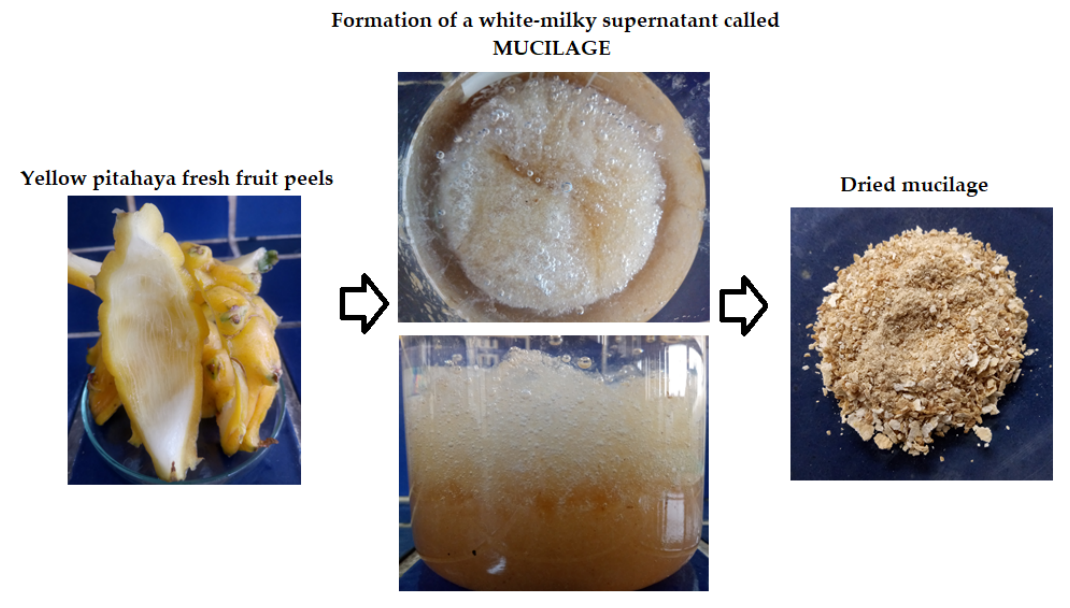
Figure 7. Selected photographs of the process of extracting mucilage from the peels of the fruit of yellow pitahaya.